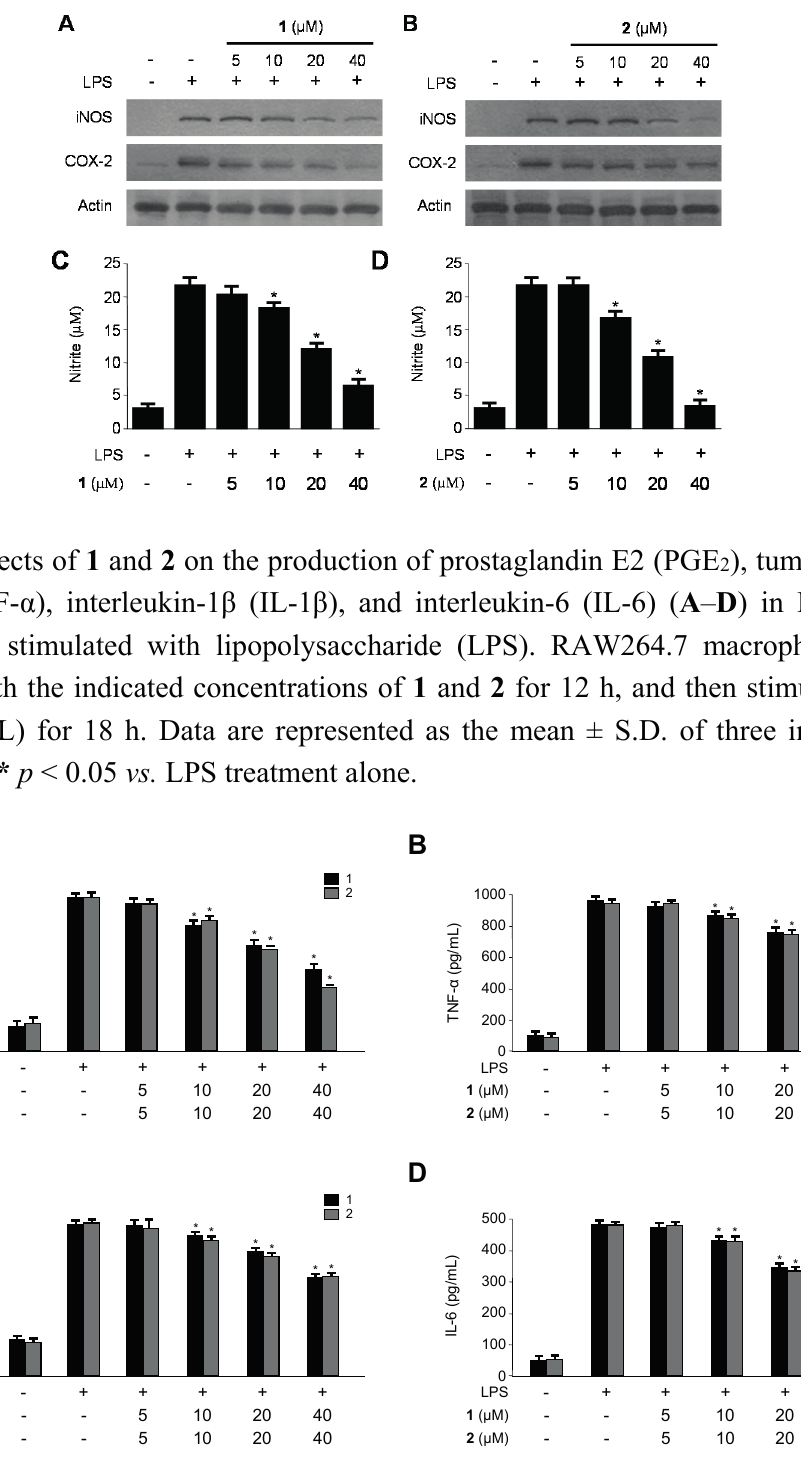
Figure 4. Effects of 1 and 2 on protein expression of inducible nitric oxide synthase (iNOS) and cyclooxygenase-2 (COX-2) ( A , B ); and on the production of nitrite ( C , D ) in RAW264.7 macrophages stimulated with lipopolysaccharide (LPS). RAW264.7 macrophages were pretreated with the indicated concentrations of 1 and 2 for 12 h, and then stimulated with LPS (1 μ g/mL) for 18 h ( A – D ). Data are represented as the mean ± S.D. of three independent experiments. Western blot analysis was representative of three independent experiments with similar results. * p < 0.05 vs. LPS treatment alone.